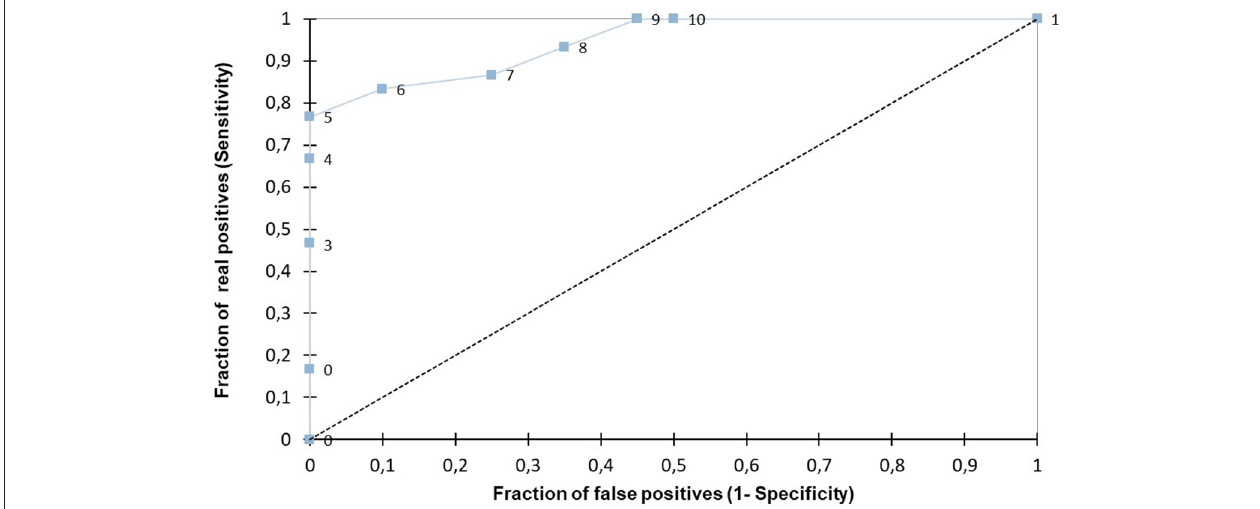
FIGURE 3 | The area under the receiving operating characteristic (ROC) curve for the pulmonary hypertension score (PHS) indicates an optimal cutoff value of 5, discriminating G2 from G1 with a sensitivity of 77% and a specificity of 100% (AUC: 0.994; p < 0.001).